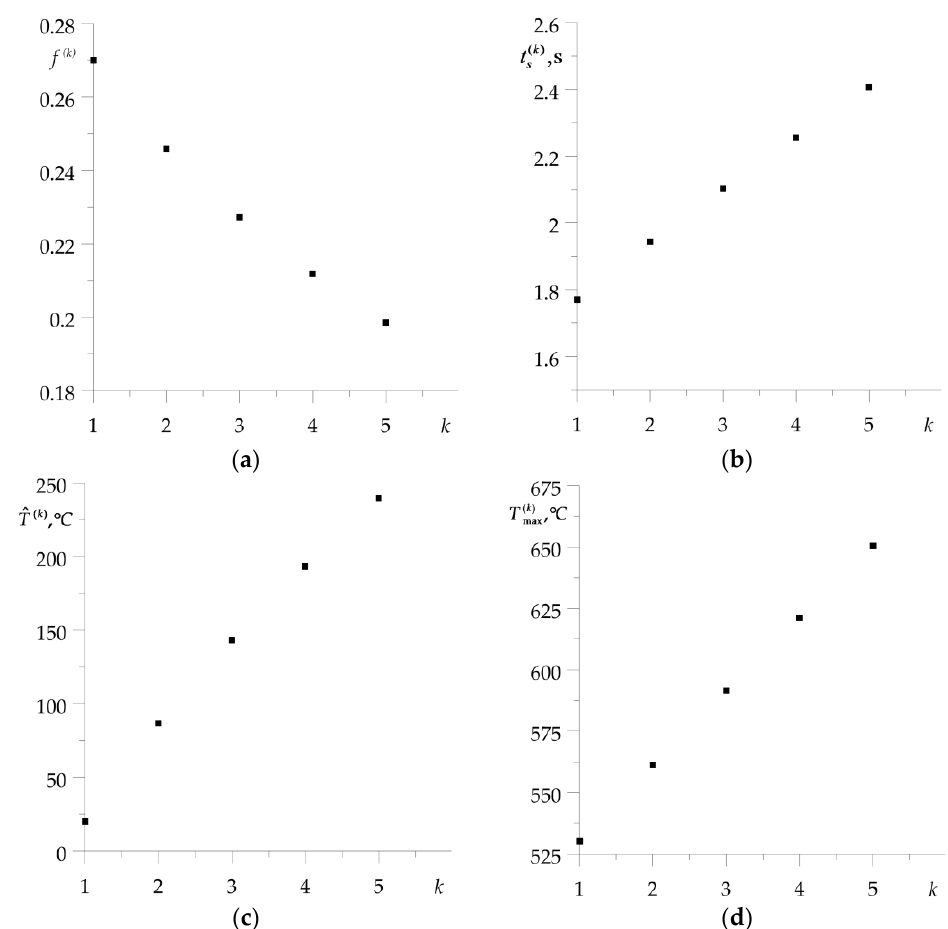
ˆ T ( k ) (24); ( d ) maximum temperature on the friction